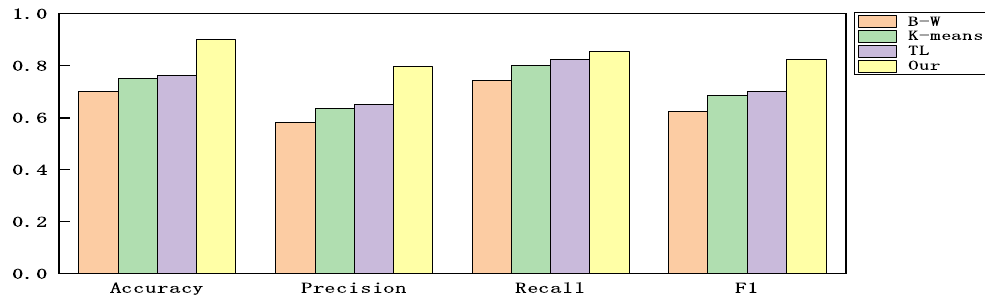
Figure 4. The results for DARPA